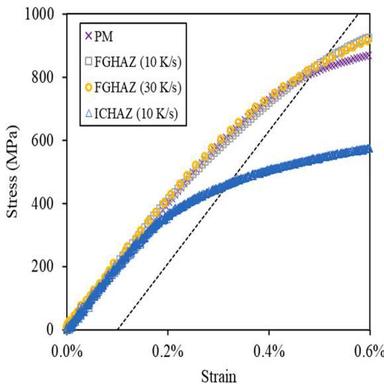
0.1% proof stress calculation for PM, FGHAZ (10 K/s), FGHAZ (30 K/ s), and ICHAZ (10 K/s).